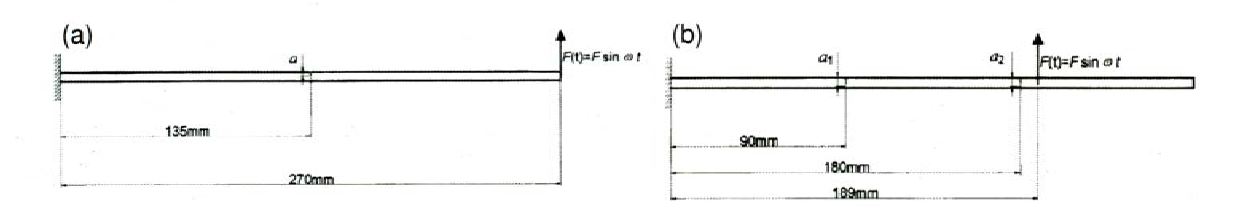
Figure 6: Damaged structures: weakly nonlinear (a) and strongly nonlinear (b).